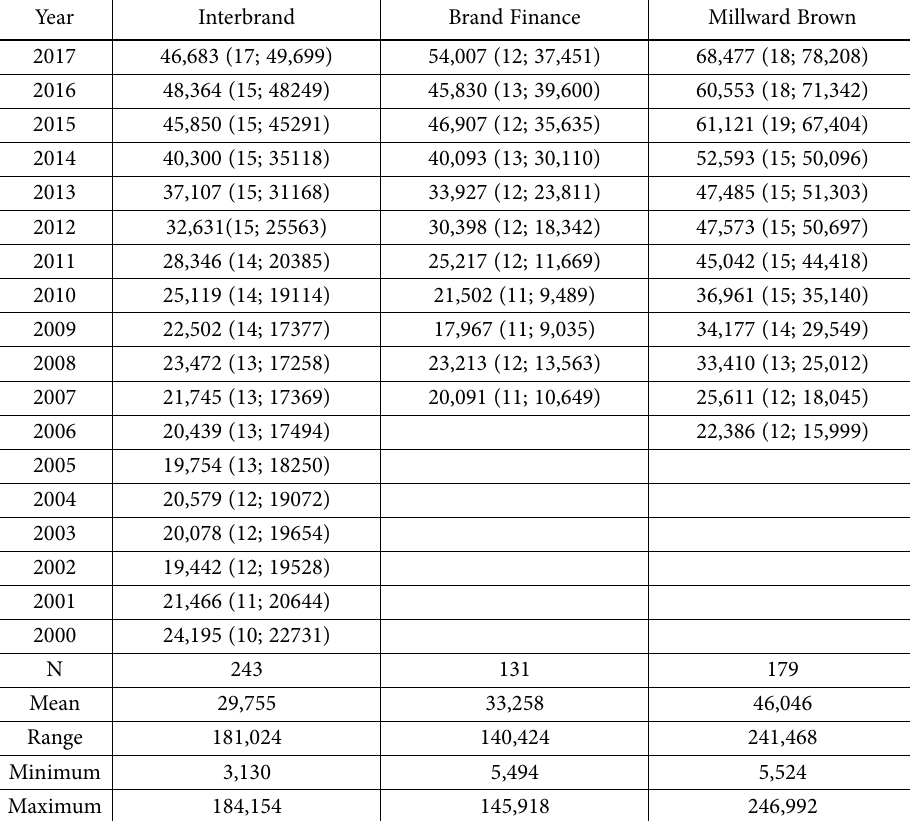
Table 2. The mean brand value of each consultancy company for the high-value brands of the IT sector per year (nominal values in millions $), number of analysed companies ( n ), standard deviation ( s ) and other descriptive statistics